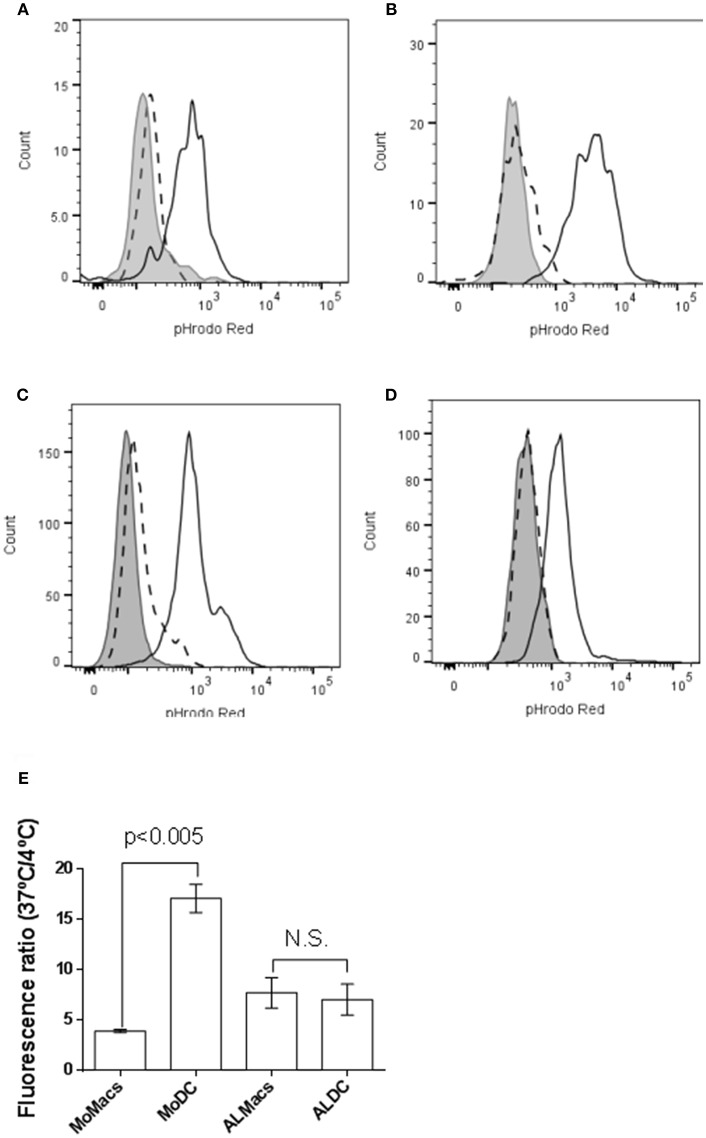
Phagocytosis activity of bovine afferent lymph and monocyte-derived cells. Phagocytic activity of MoMacs (A), MoDCs (B), ALMacs (C), and ALDCs (D) was assessed using pHrodo Red E. coli BioParticles. Each histogram is representative of cells from 5 different animals. Gray histograms represent background fluorescence; dashed histograms represent cells incubated with pHrodo Red E. coli bioparticles at 4°C and solid white histograms represents fluorescence of cells incubated with bioparticles at 37°C. (E) Quantification of phagocytosis for each cell type. Bars represent the mean fluorescence intensity ratios (37°C/4°C) for cells from 5 different animals. Error bars indicate standard deviations.